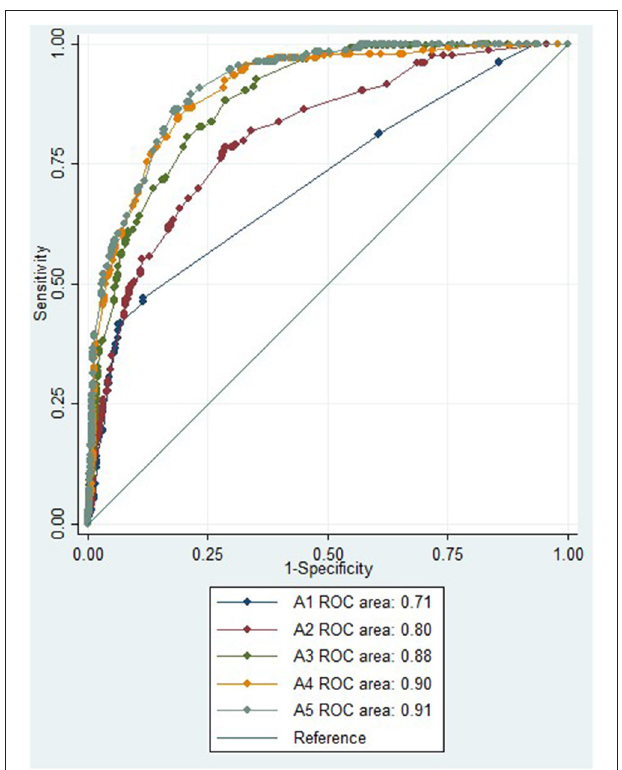
FIGURE 1 | ROC for multiple regression model to distinguish between stroke and mimic. ROC, receiver operator curve; NIHSS, National Institutes of Health Stroke Scale; CTA, computed tomography angiography; CTP, computed tomography